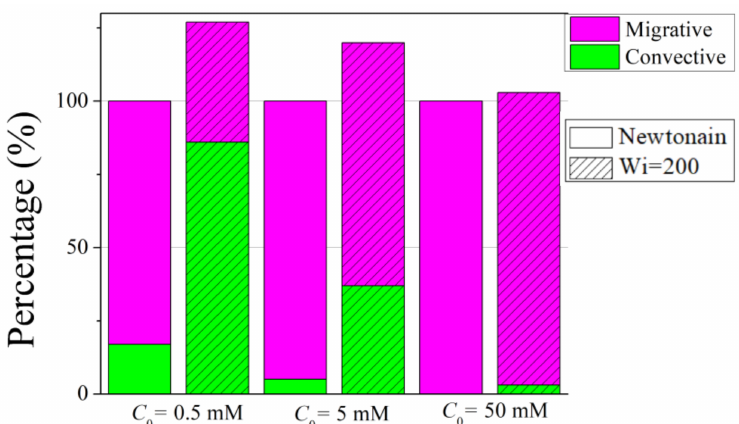
Figure 5. Percentage of the convective and migrative ionic conductance components for Newtonian and viscoelastic fluids of Wi = 200 for C 0 = 0.5 mM, 5 mM, and 50 mM, respectively. For clarity, the percentage of the components for viscoelastic fluid is shown with respect to the Newtonian fluid under the same bulk salt concentration. Thus, the total height for viscoelastic fluid becomes 127%, 120%, and 103% for C 0 = 0.5 mM, 5 mM, and 50 mM, respectively.